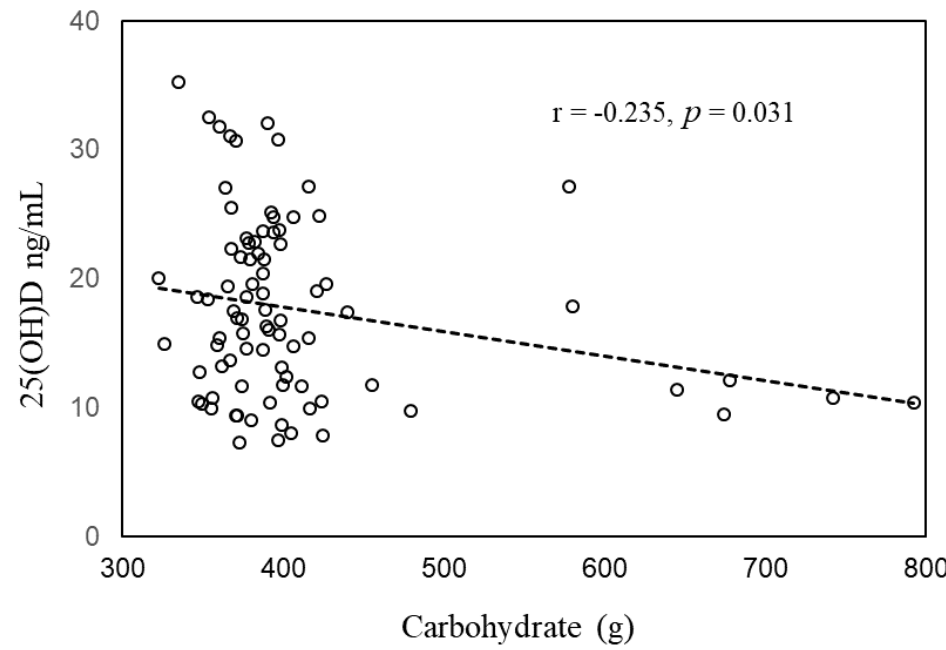
Figure 3. Correlation between serum 25(OH)D level and amount of carbohydrate intake among pregnant women with ≥ 300 g/day carbohydrate intake ( n = 85). Table 5. Multiple linear regression analysis of predictive factors for 25(OH)D levels in subjects with 300 g/day carbohydrate intake.